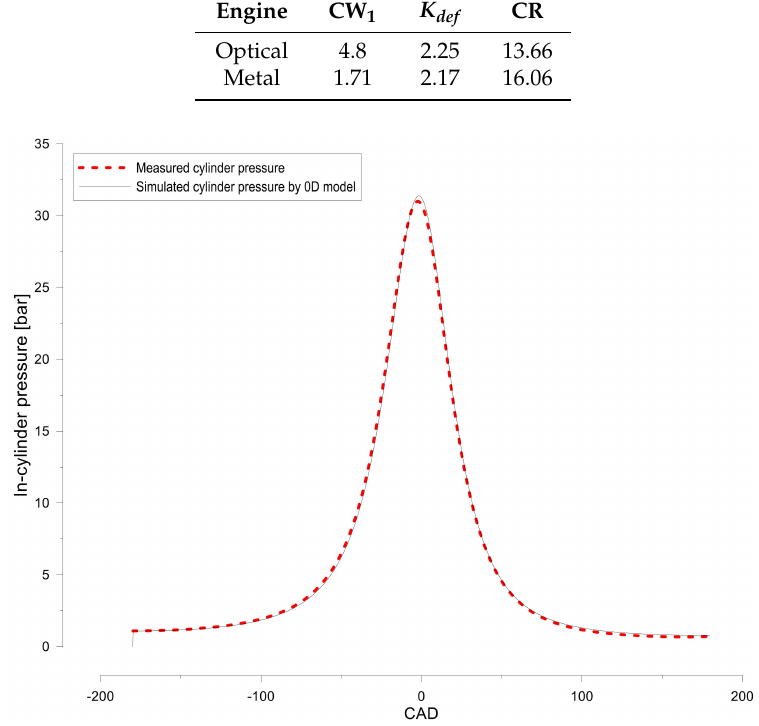
Figure 16. Cylinder pressure comparison: the OD model versus the